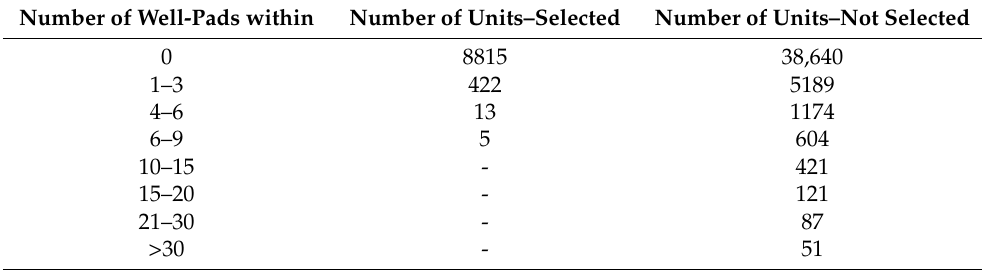
Table 2. Summary for the count of oil and gas well pads located within a range of cells for the selected scenario (S4–30% conservation target) and for units not selected.